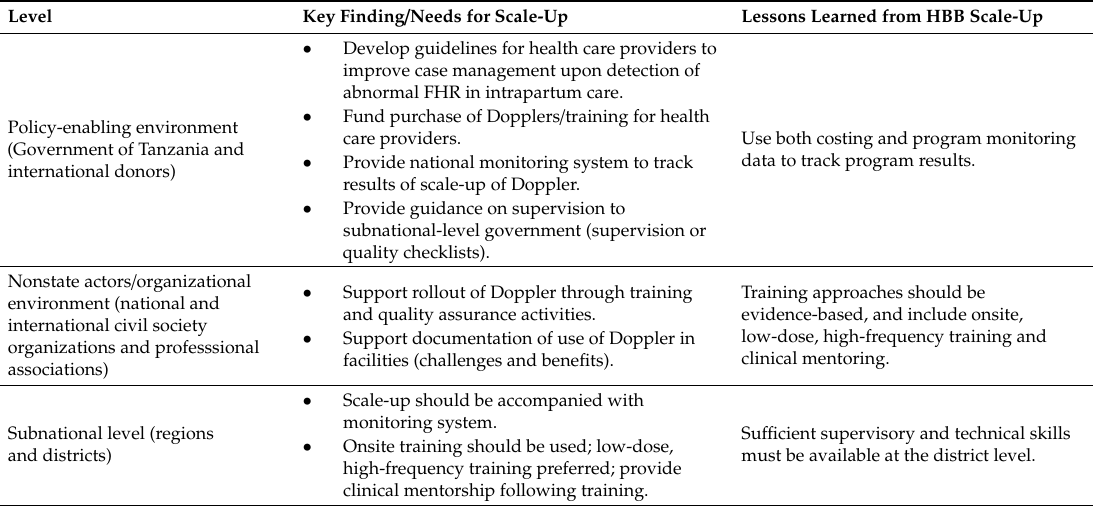
Table 4. Policy and organizational-level factors a ff ecting scale-up of Doppler in